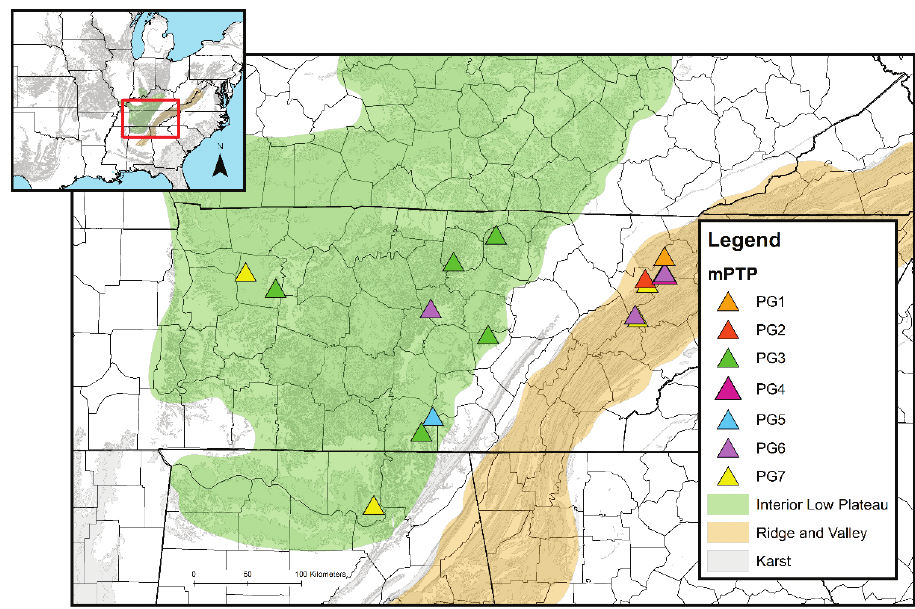
Figure 7. Geographic distribution of MOTUs generated from the mPTP delimitation method in rela- tion to karst adapted from Weary and Doctor (2014). Triangles represent cave populations. The numbers associated with each unique color corresponds to the associated mPTP MOTUs found in Table